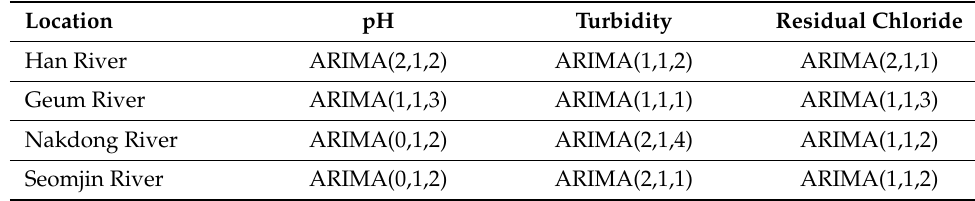
Table 4. Optimal ARIMA model for each